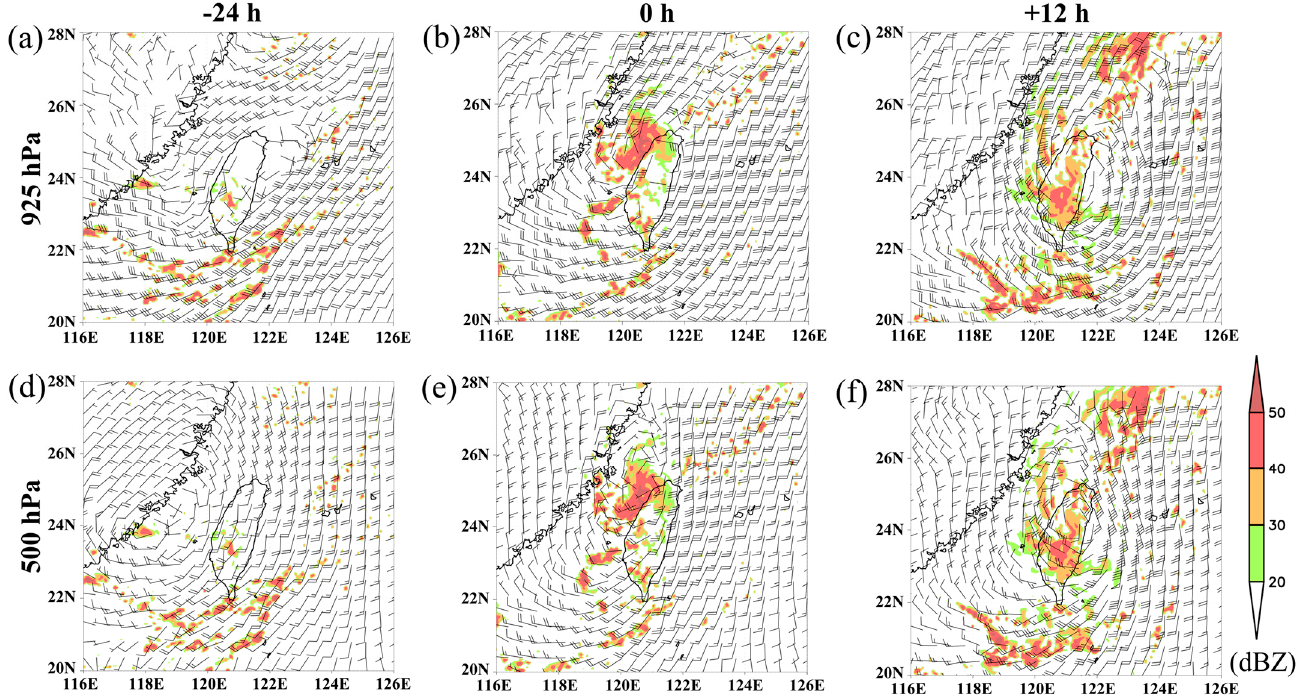
Figure 6. Simulated maximum reflectivity (shading; dBZ) and ( a – c ) 925 hPa, ( d – f ) 500 hPa wind (barbs; kts) in CTRL at ( a , d ) 0000 UTC 30 August 2013, ( b , e ) 0000 UTC 31 August 2013, and ( c , f ) 1200 UTC 31 August 2013.